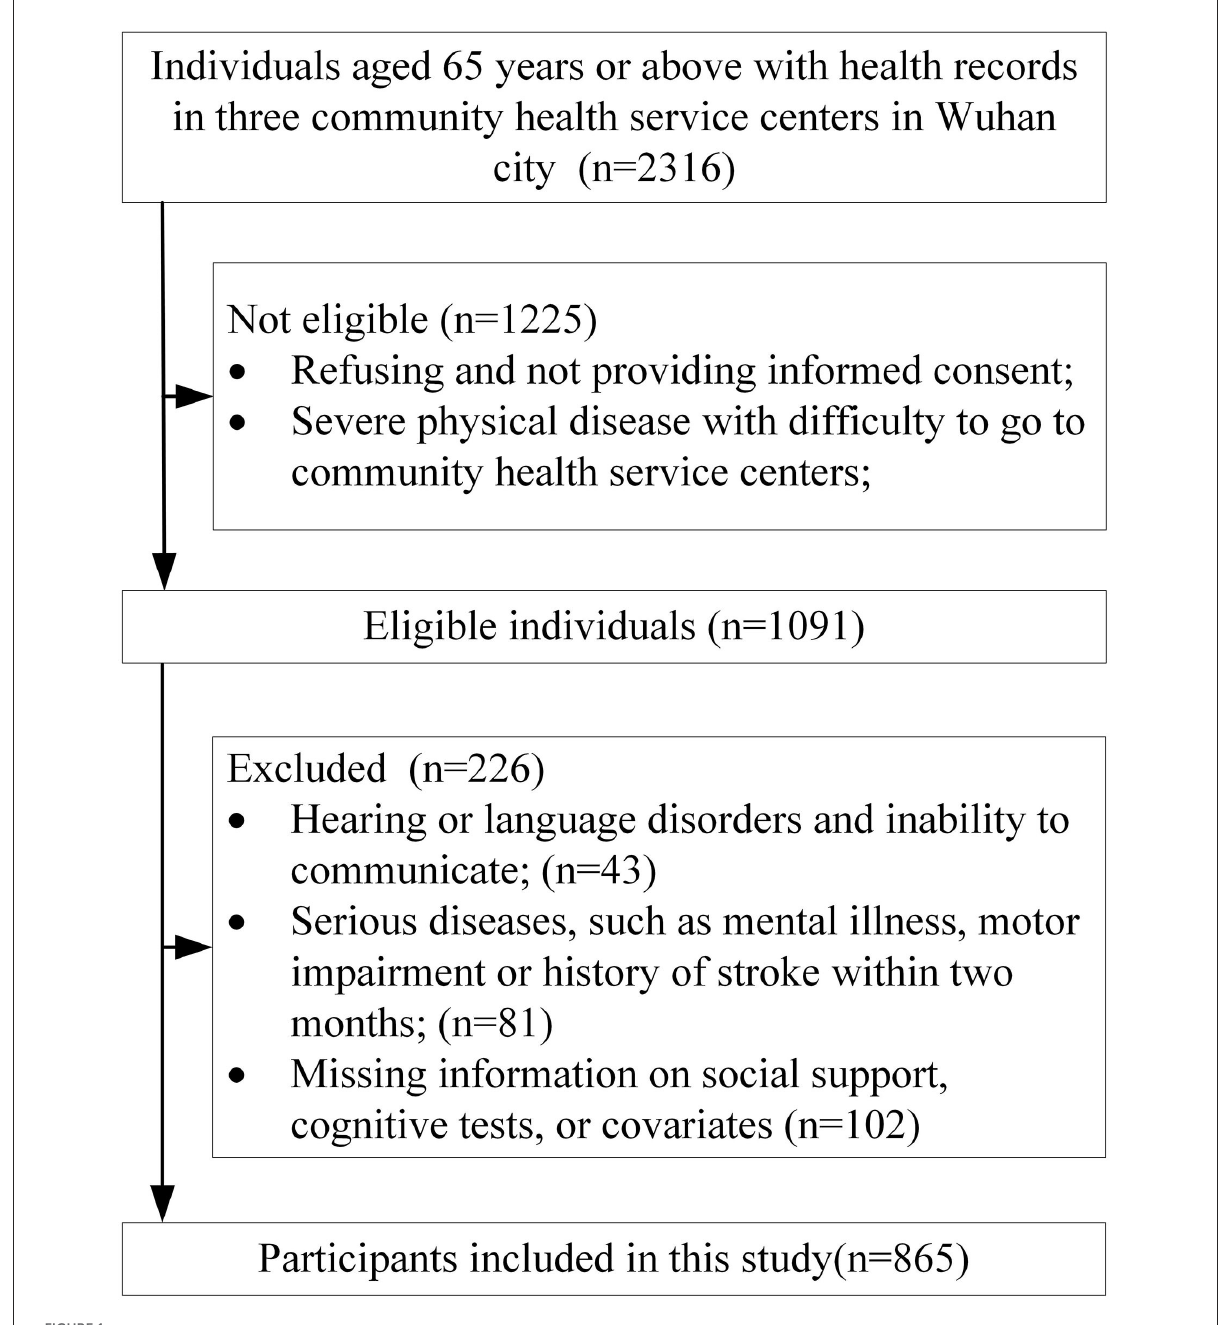
FIGURE1 The flow chart of the inclusion and exclusion of study